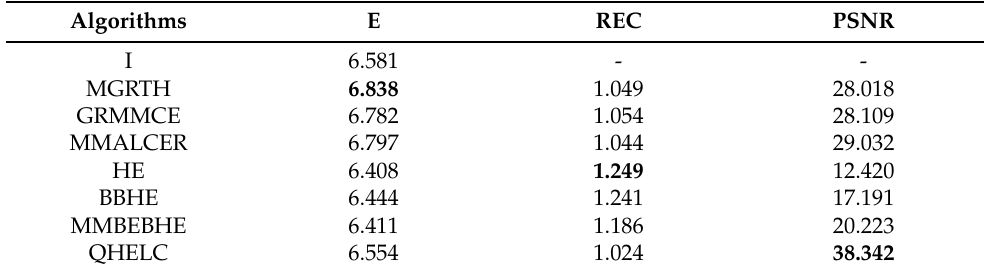
Table 3. Average results obtained by the compared algorithms. Algorithms E REC